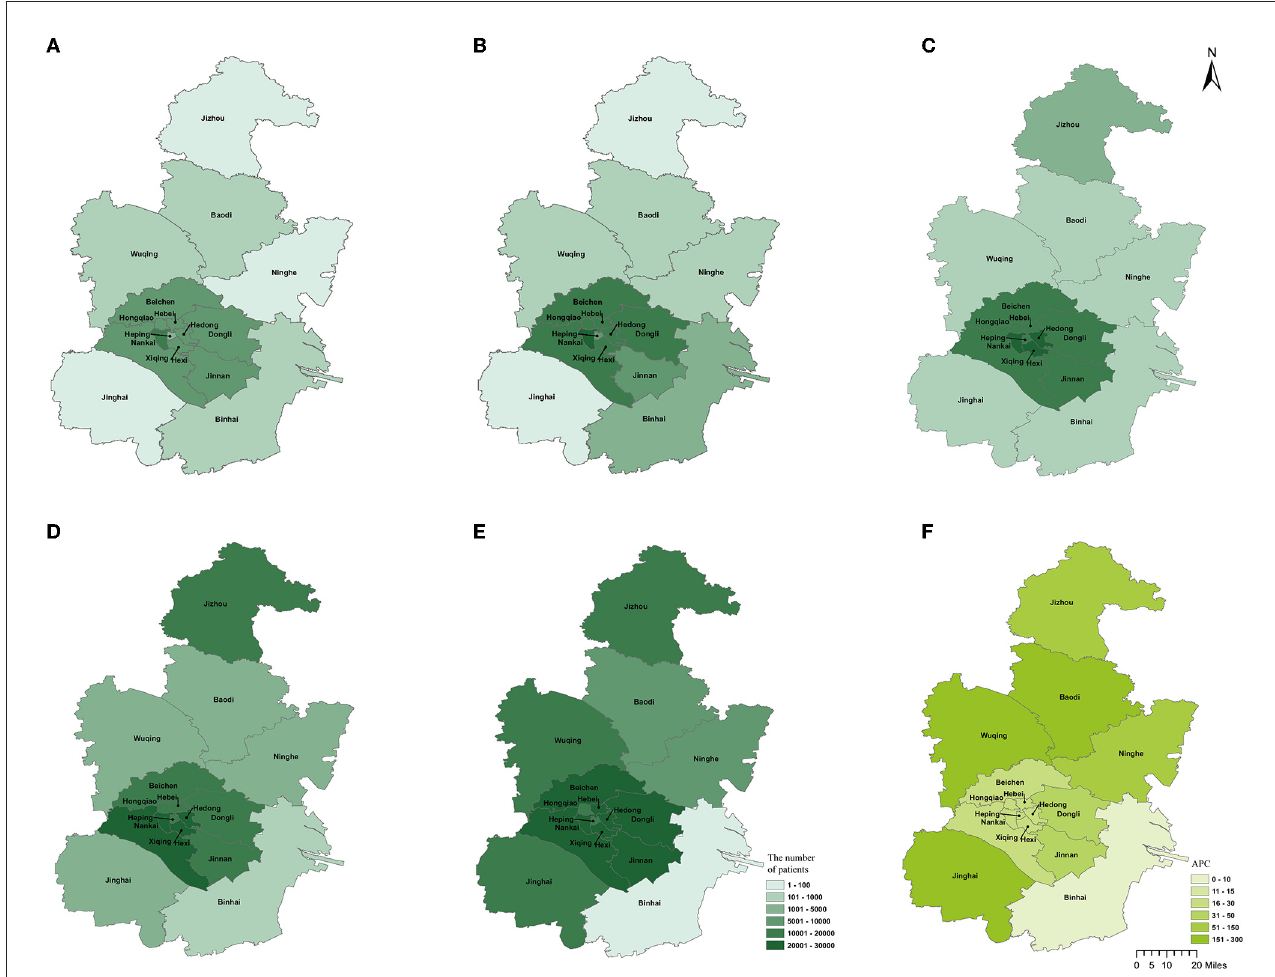
FIGURE4 Geographical distribution and APC of EMS patients in Tianjin. (A) The number of patients using EMS in 2017; (B) the number of patients using EMS in 2018; (C) the number of patients using EMS in 2019; (D) the number of patients using EMS in 2020; (E) the number of patients using EMS in 2021; (F) APC of EMS patients in Tianjin from 2017 to